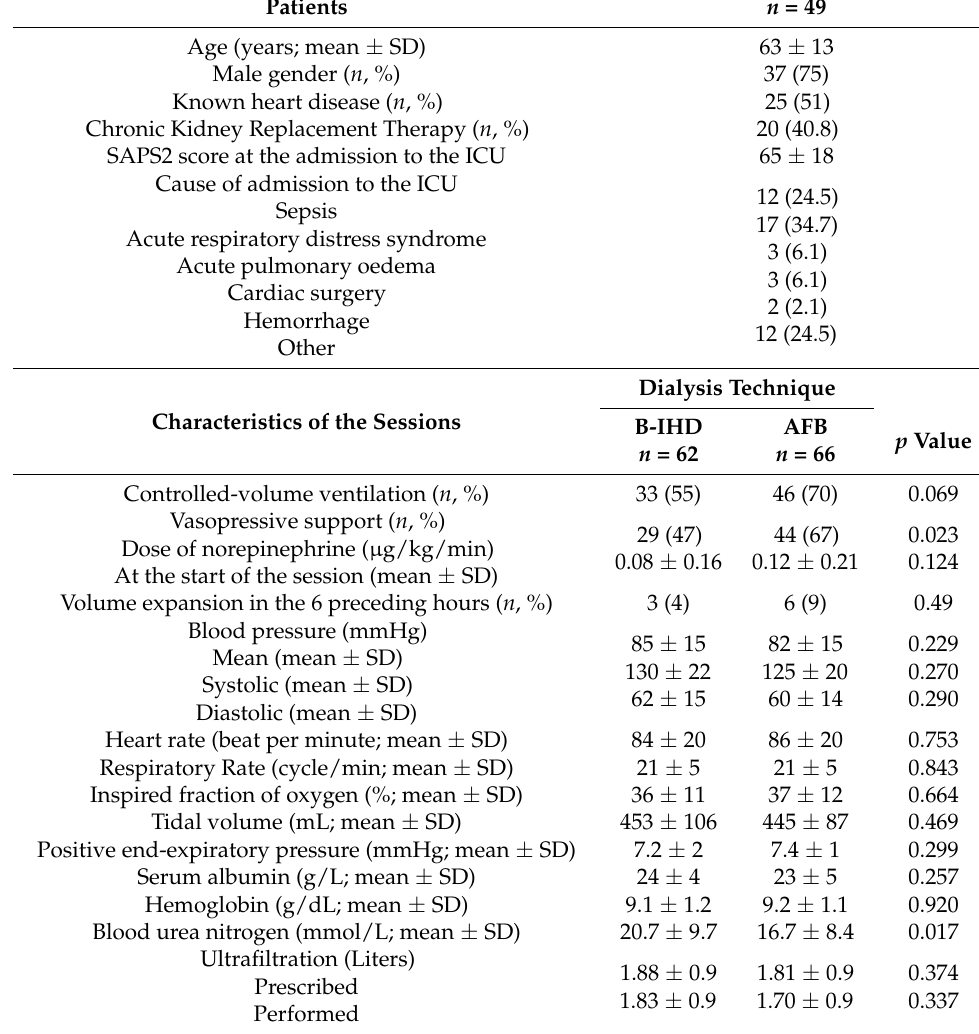
Table 1. Characteristics of patients and dialysis sessions. SD, standard deviation; ICU, intensive care unit; B-IHD, bicarbonate-based intermittent hemodialysis; AFB, acetate-free